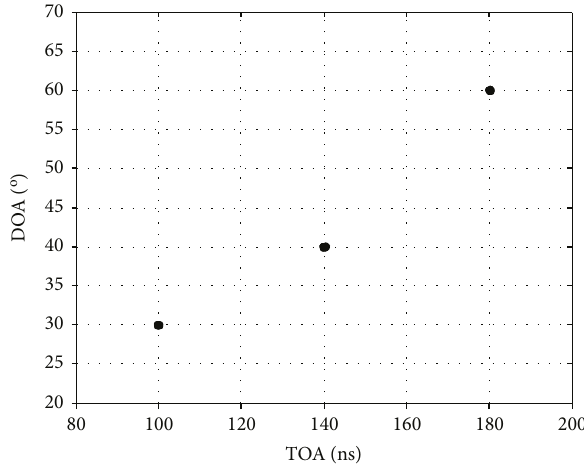
Figure 2: The scatter plot of joint TOA and DOA estimation, SNR =0dB.